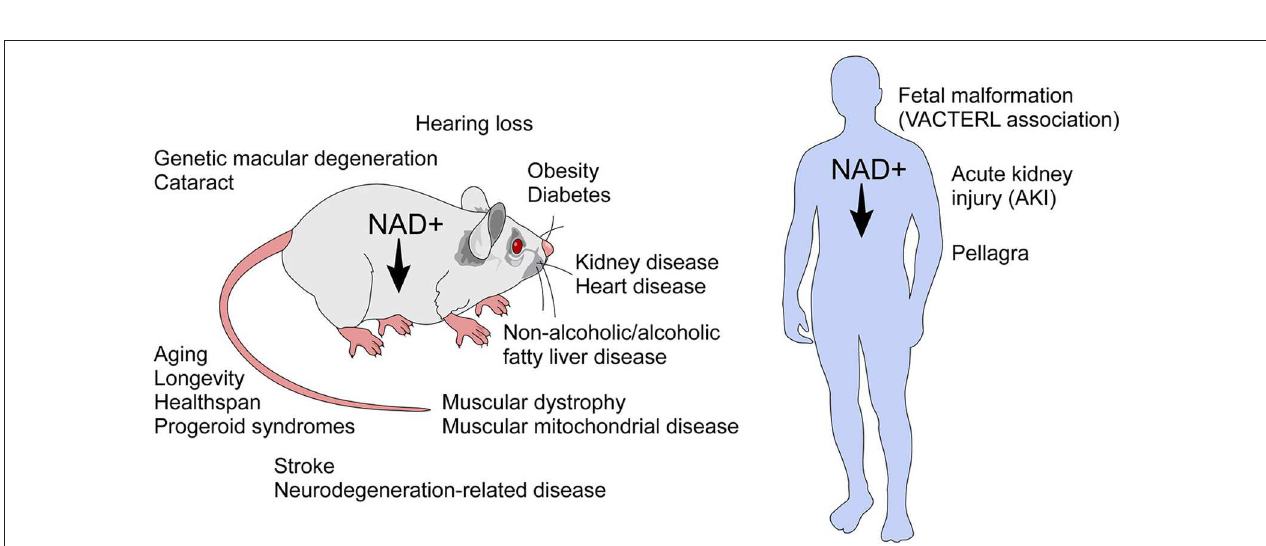
FIGURE 4 | NAD + decline has been implicated in several diseases and age-related conditions . NAD + decline has been implicated in the biology of aging and in several conditions in rodents. In humans, NAD decline has been implicated in pellagra, acute kidney injury, and the fetal malformation syndrome